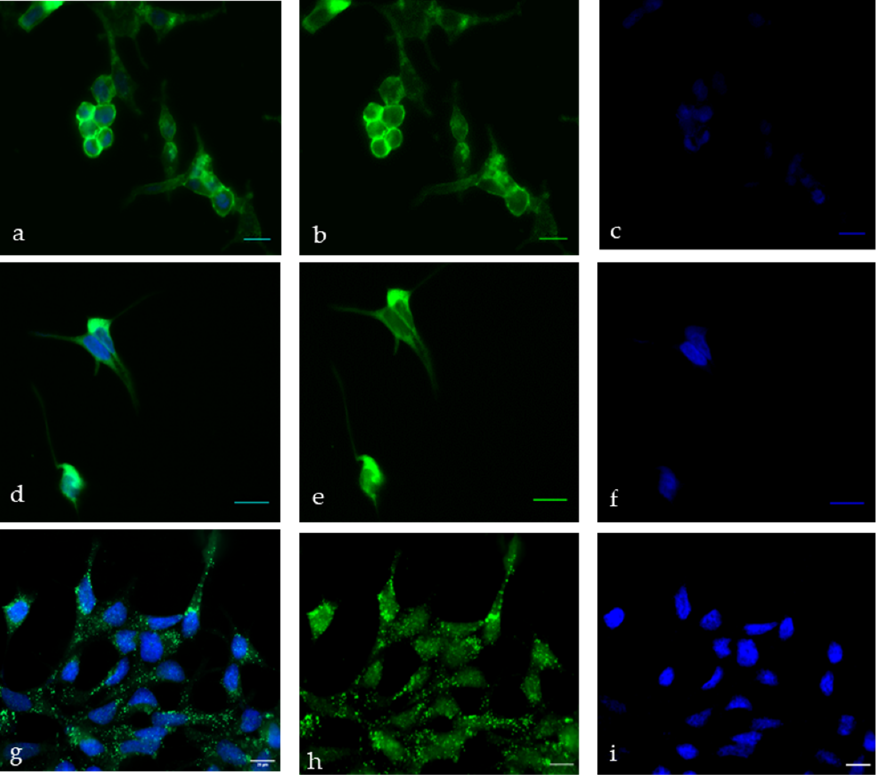
Figure 2. Immunofluorescence staining of LNCaP cells for ( b ) PSMA, ( e ) PSA, ( h ) PSCA and ( c , f , i ) Hoechst 33258 was used for nuclear counterstaining. Overlay of nuclear staining and marker-specific staining showing ( a ) PSMA, ( d ) PSA and ( g ) PSCA. Scale bares indicate 20 µm.